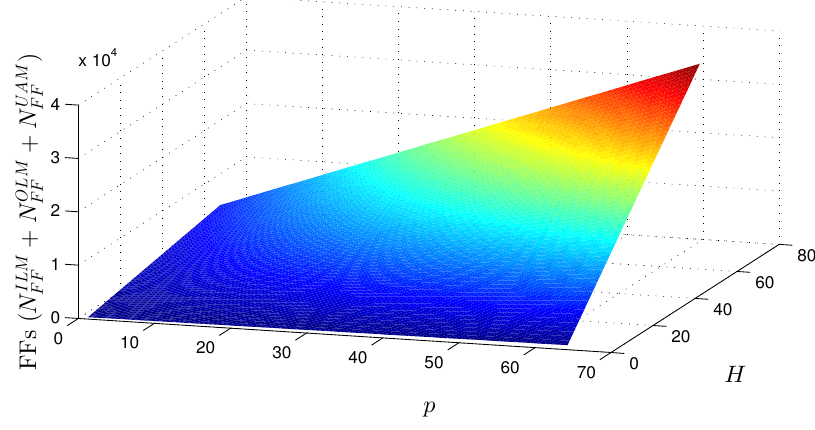
Figure 13. Area occupied (flip-flops) for different numbers of inputs, p , centers, H and M = 1 .